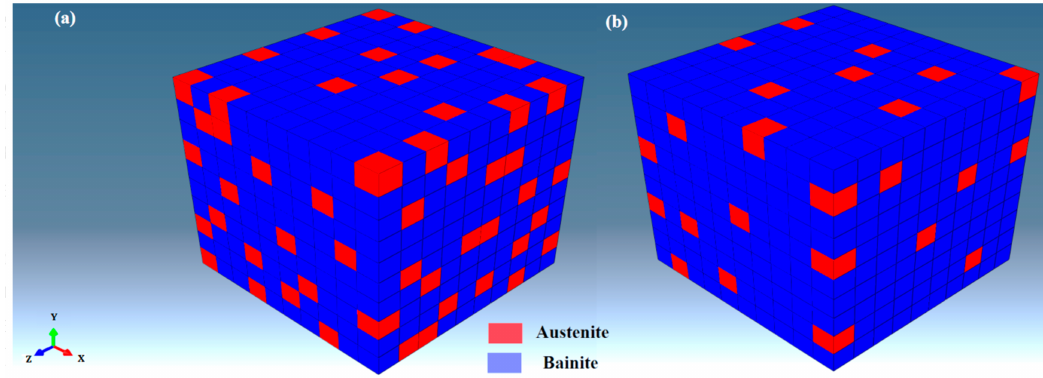
Figure 7. ( a ) Illustration of an RVE instantiation for the B1 sample and ( b ) illustration of an RVE instantiation for the B2 sample in